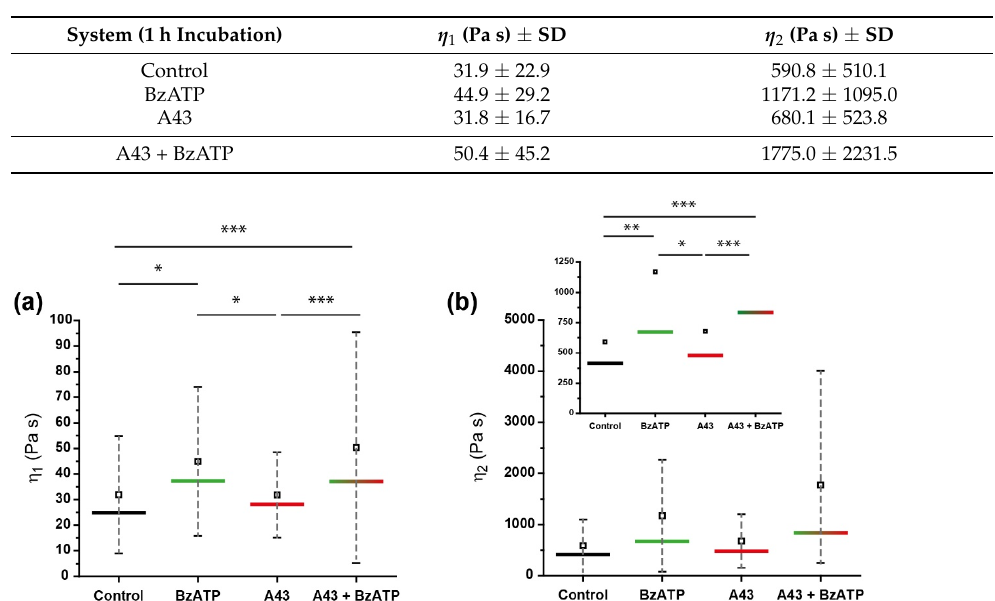
Table 3. Statistics on pause segment (mean viscous moduli, η 1 and η 2 ). Error values indicate the standard deviation (SD).